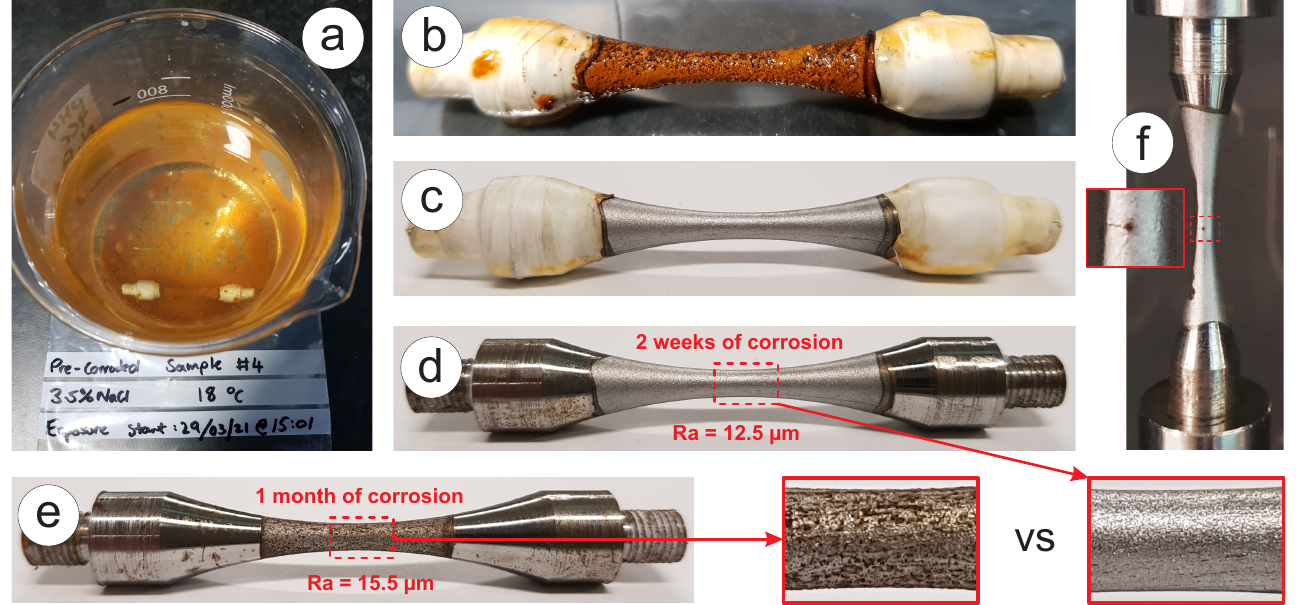
Figure 4. Pre-corroded specimen for ultrasonic test: ( a ) 3.5% NaCl solution with the submerged specimen; ( b ) rust layer on the specimen; ( c ) washed specimen with thread seal tape; ( d ) specimen after 2 weeks of corrosion; ( e ) specimen after 1 month of corrosion; ( f ) specimen at the end of the test with a crack in the